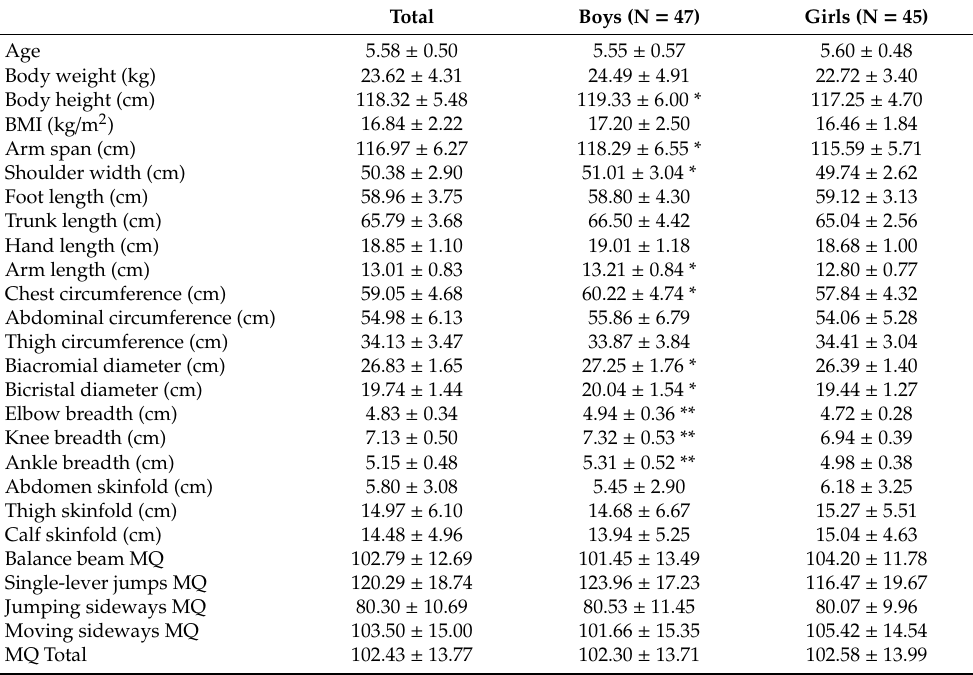
Table 2. Characteristics for the total sample and stratified by